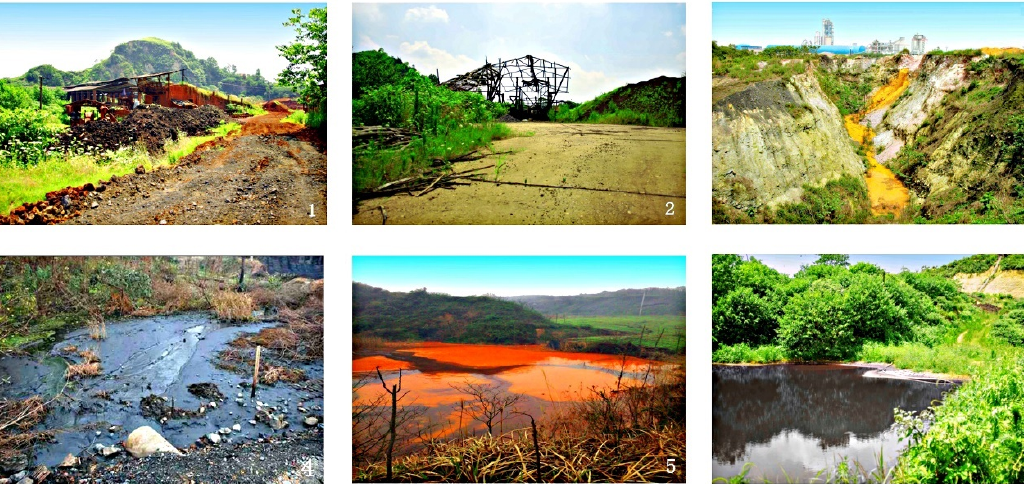
Figure 1. Overview of the study area. ( 1 ). Abandoned mining enterprise. ( 2 ). Slag stacking site. ( 3 ). Current situation of soil erosion. ( 4 ). Current situation of sewage discharge. ( 5 ). Contaminated wetland. ( 6 ). Contaminated wetland.